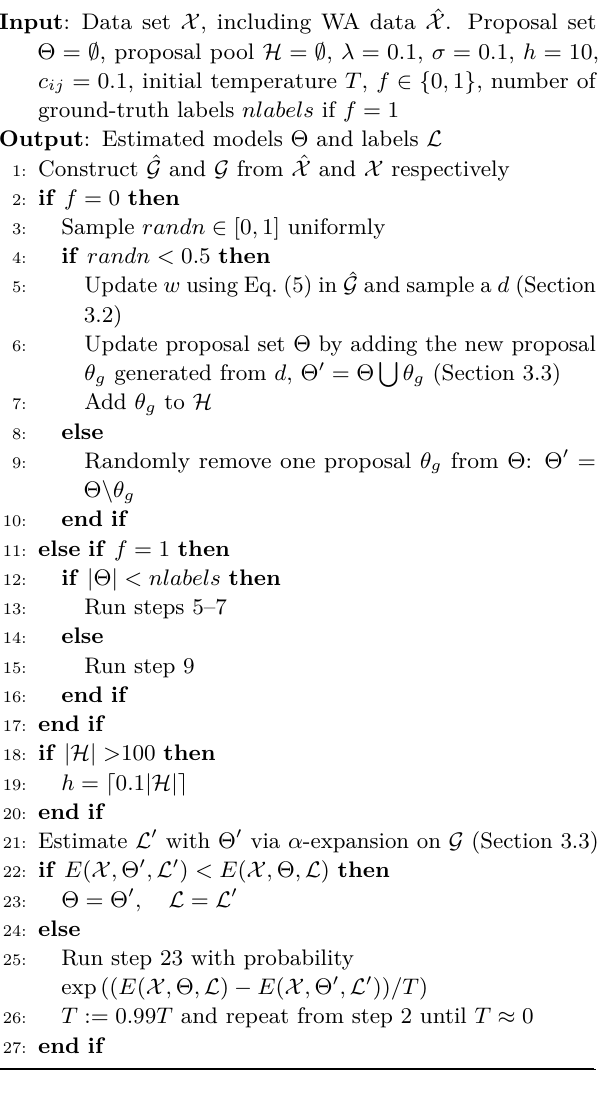
Algorithm 1 Geometric multi-model fitting with weak annotations